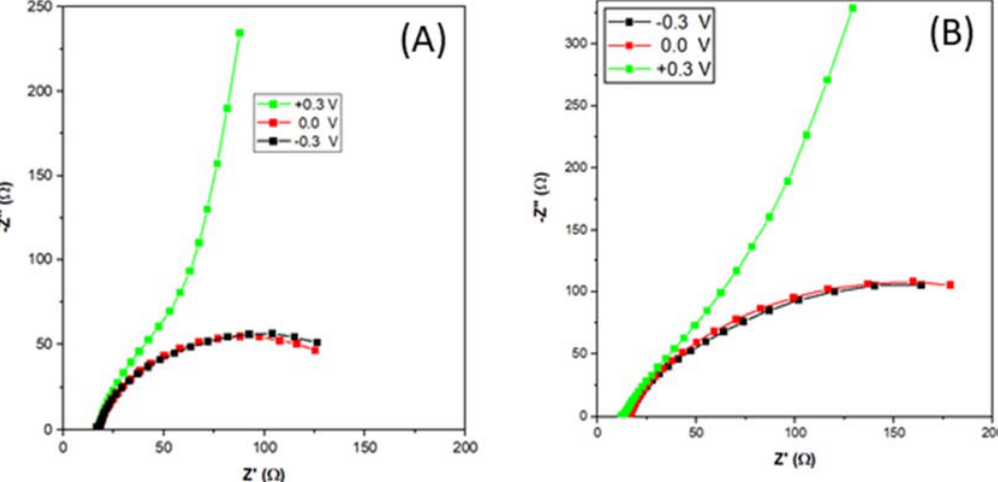
Figure 9. Electrochemical impedance spectroscopy (EIS) of Pd 4 Ag 2 Ni 1 /C ( A ) and PdAgNi/C ( B ) at − 0.3 V, 0.0 V, and 0.3 V vs. NHE.